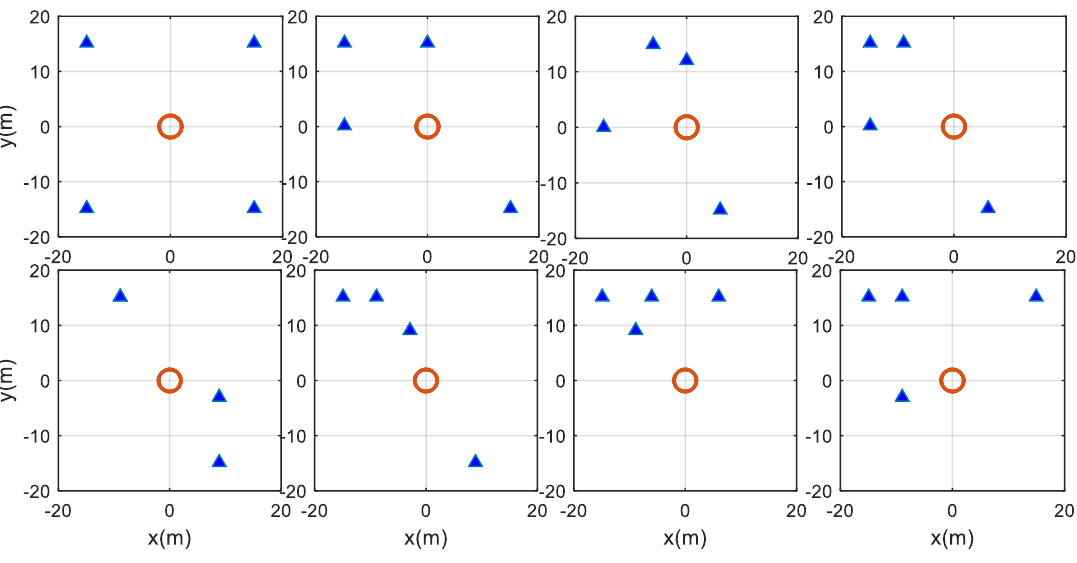
Figure 11. Eight different anchor geometry scenarios.